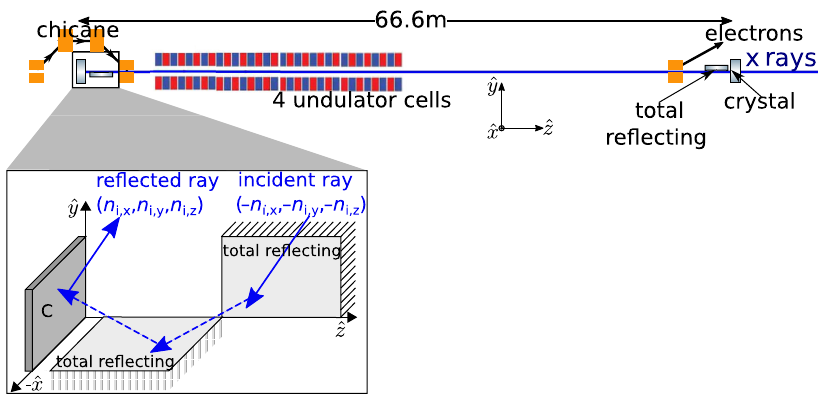
FIG. 1. Schematic layout of the CBXFEL-demonstrator setup. The inset shows the retroreflector used for backscattering, where the reflected ray will always be antiparallel to the incoming one. C represents the diamond Bragg reflector crystal. The angles and dimensions shown here are strongly exaggerated for better